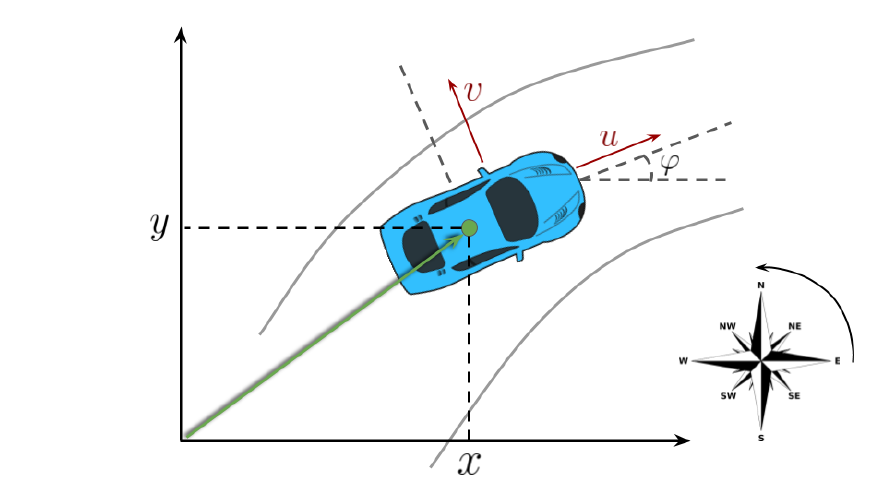
Figure 3. The adopted sensor measurement reference frame. u and v are the longitudinal and lateral velocities; x and y are the vehicle coordinates with respect to the map origin.